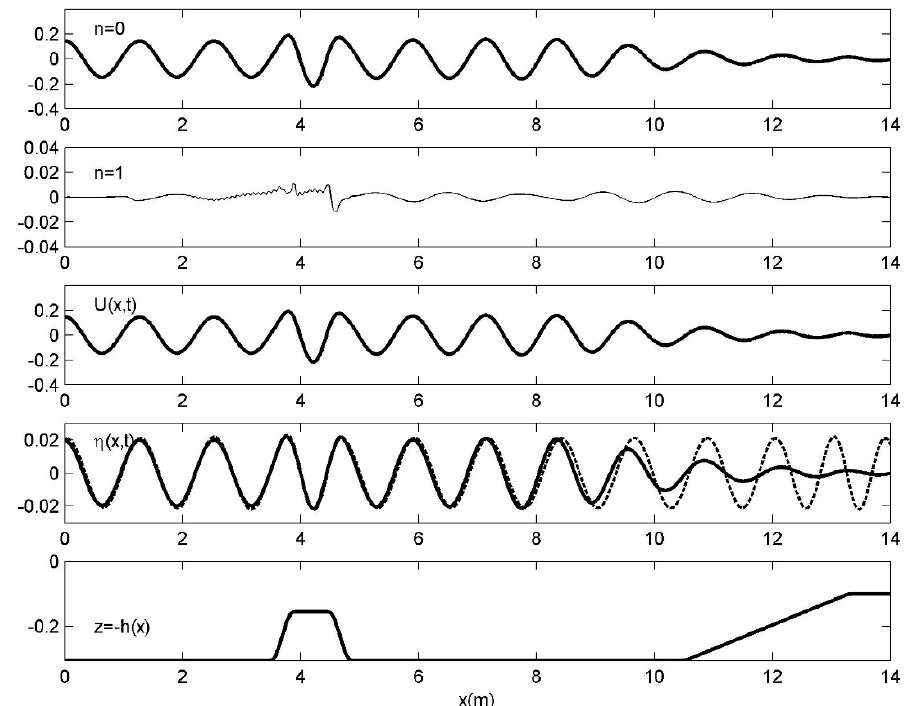
Figure 10. The same as in Figure 9, but in the presence of opposing shear current with data as shown in Figure 8.